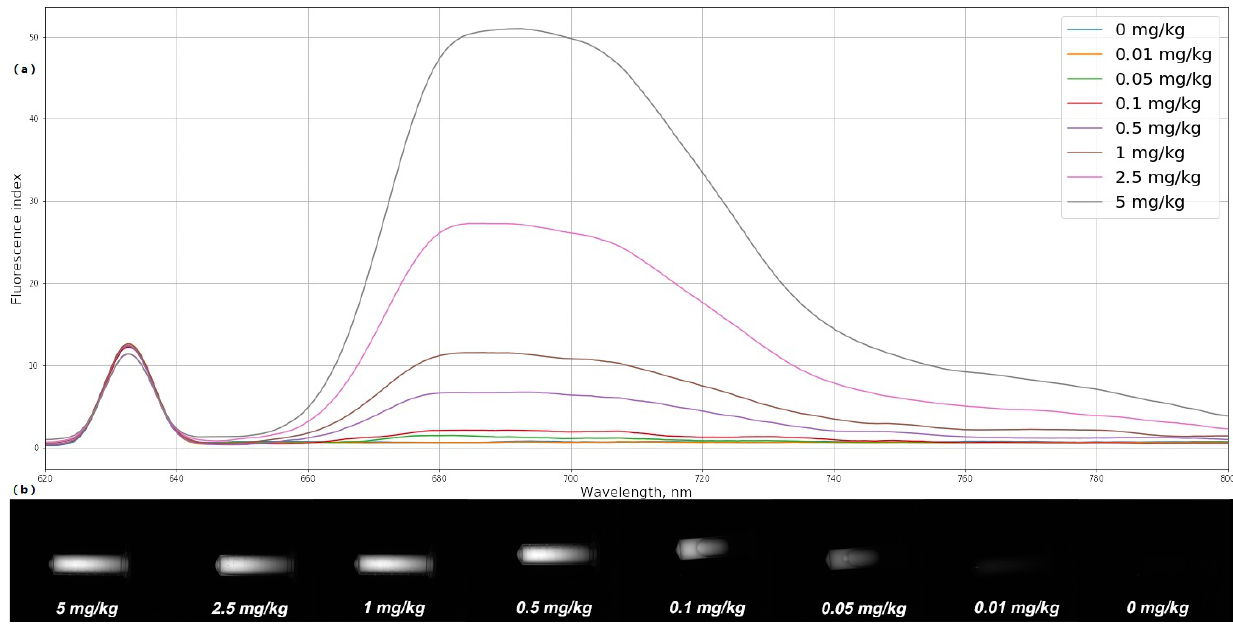
Figure 5. Fluorescence spectra of optical phantoms with MB photosensitizer at different concentrations ( a ); fluorescence images of optical phantoms with different MB concentrations obtained using a black-and-white camera and a filter ( b ).